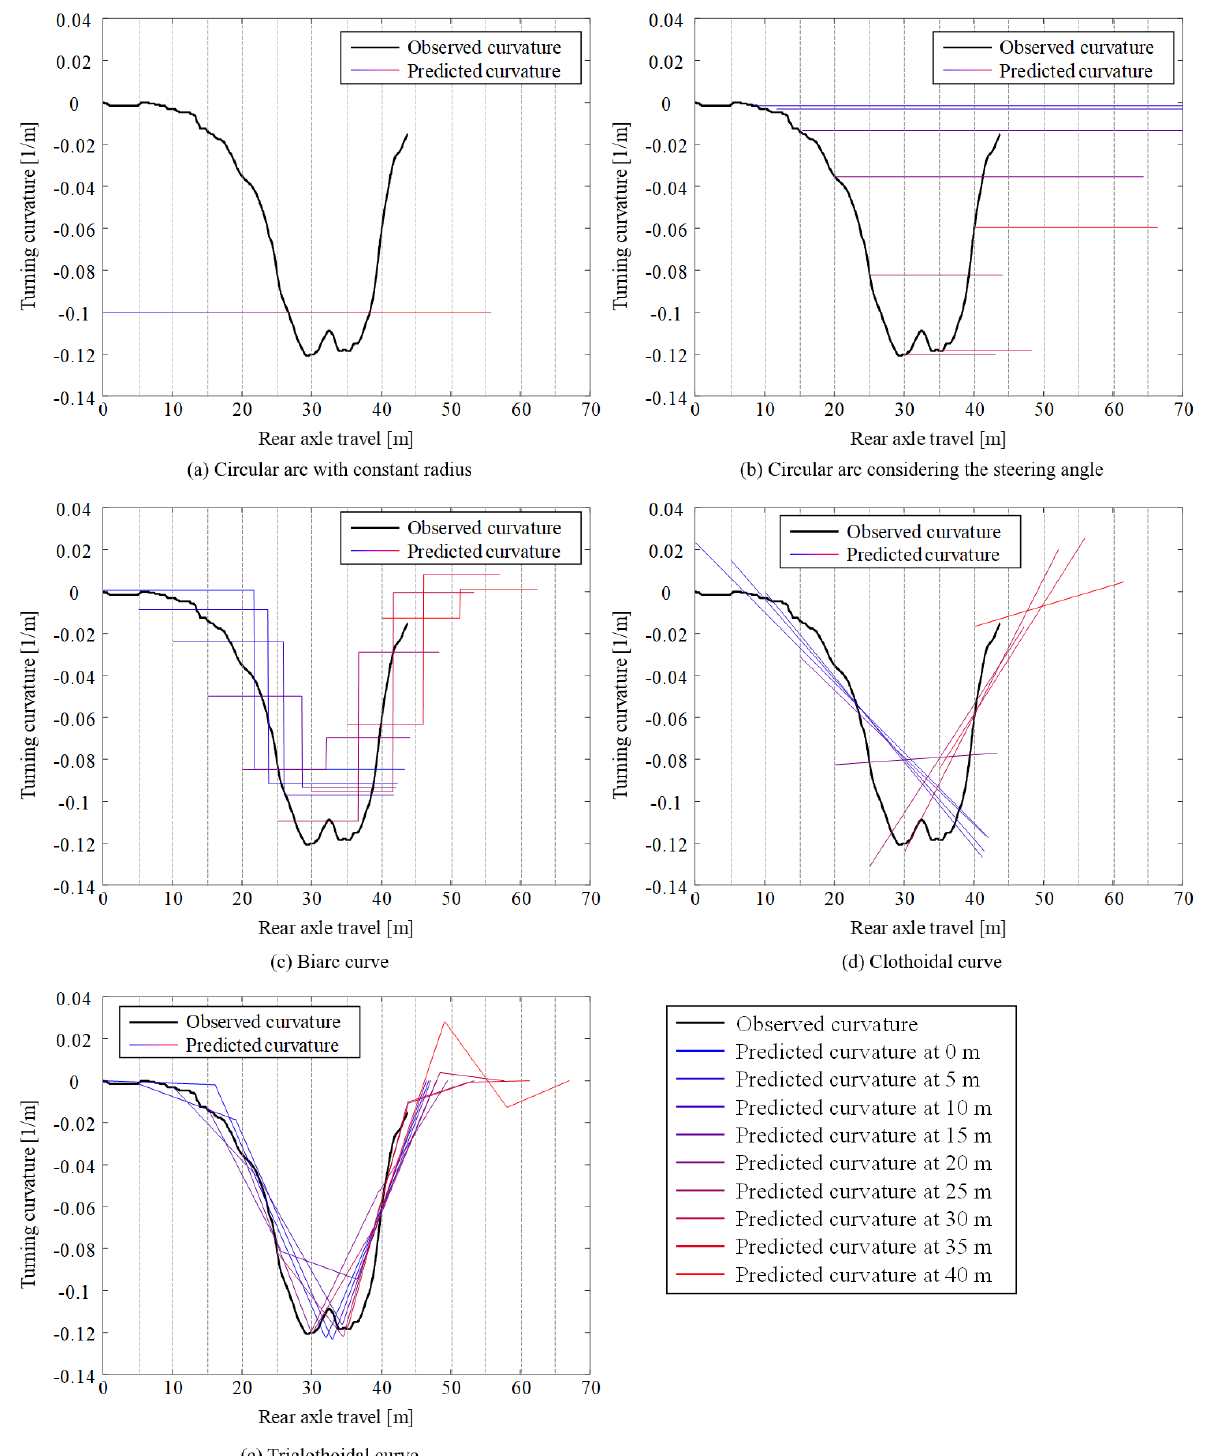
Figure 7. An example of the trajectory prediction in a real intersection by trajectory prediction methods: ( a ) circular arc with constant radius; ( b ) circular arc considering the steering angle; ( c ) Biarc curve; ( d ) Clothoidal curve; and ( e ) Triclothoidal curve. The prediction methods that require definition of the terminal point could predict the trajectory with high accuracy before getting into the intersection. The Triclothoidal curve, especially, could predict the trajectory with fewer deviations from the actual